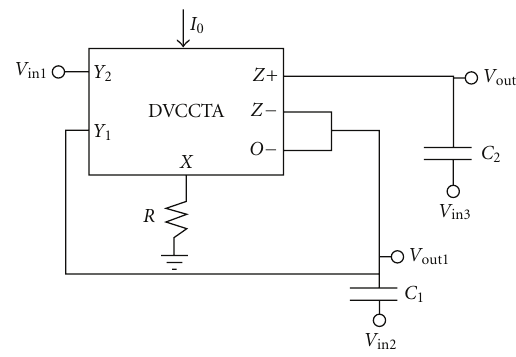
Figure 3: Proposed universal voltage-mode filter. Table 4: The I in1 , I in2 , and I in3 values selection for each filter function